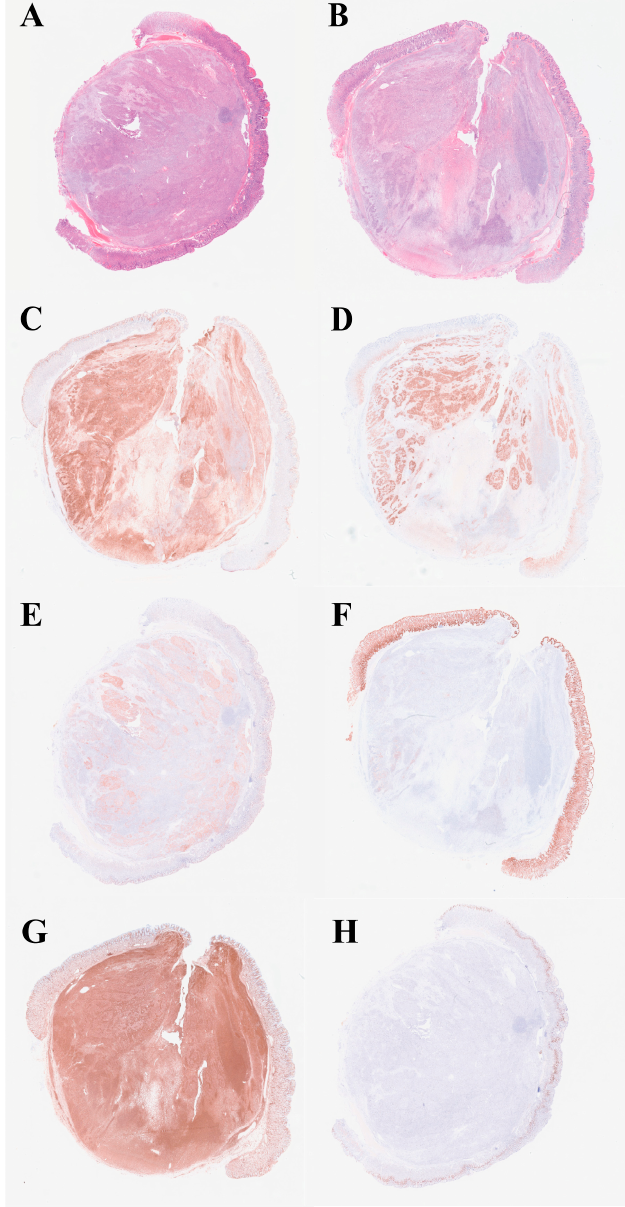
Figure 4. Hematoxylin-eosin staining (H&E) and IHC profile. ( A , B ) Histologically, the lesion had a biphasic pattern with spindle cells and epithelioid cells (in different layer, H&E, × 40). ( C ) CD10 was positive in both components (IHC, × 40). ( D ) CD56 was positive in the epithelioid part (IHC, × 40). ( E ) S100 was expressed in the epithelioid component (IHC, × 40). ( F ) EMA was focally expressed in the epithelioid part (IHC, × 40). ( G ) Vimentin was positive in both components (IHC, × 40). ( H ) Ki-67 index was approximately 5% (IHC, ×